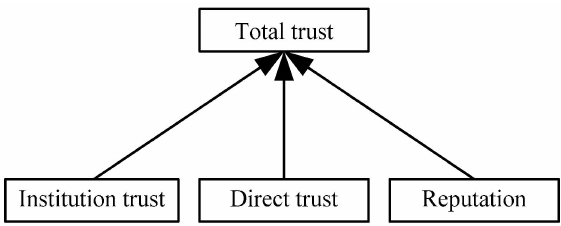
Figure 2. Schematic diagram of trust and